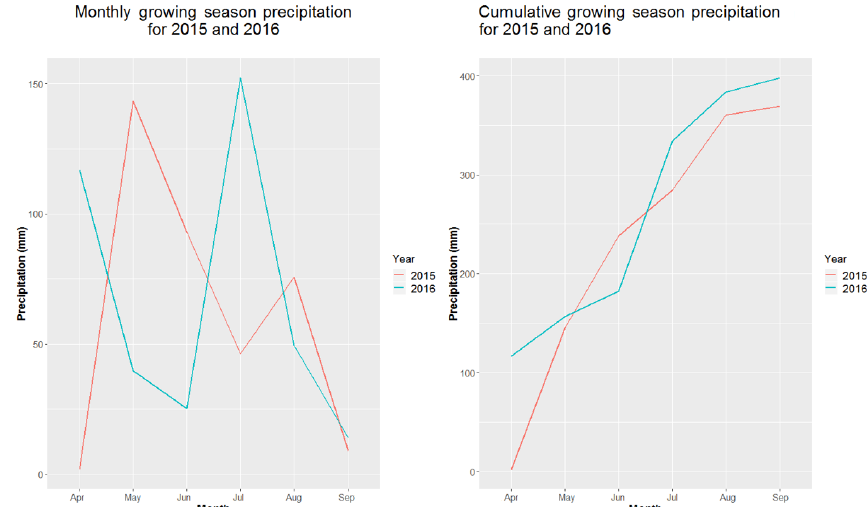
Figure 2. Monthly and cumulative growing season precipitation patterns for 2015 and 2016 recorded at a weather station located in the study area in north central SD (45.737296 ◦ N, 100 . 657540 ◦ W) (South Dakota Climate Weather,